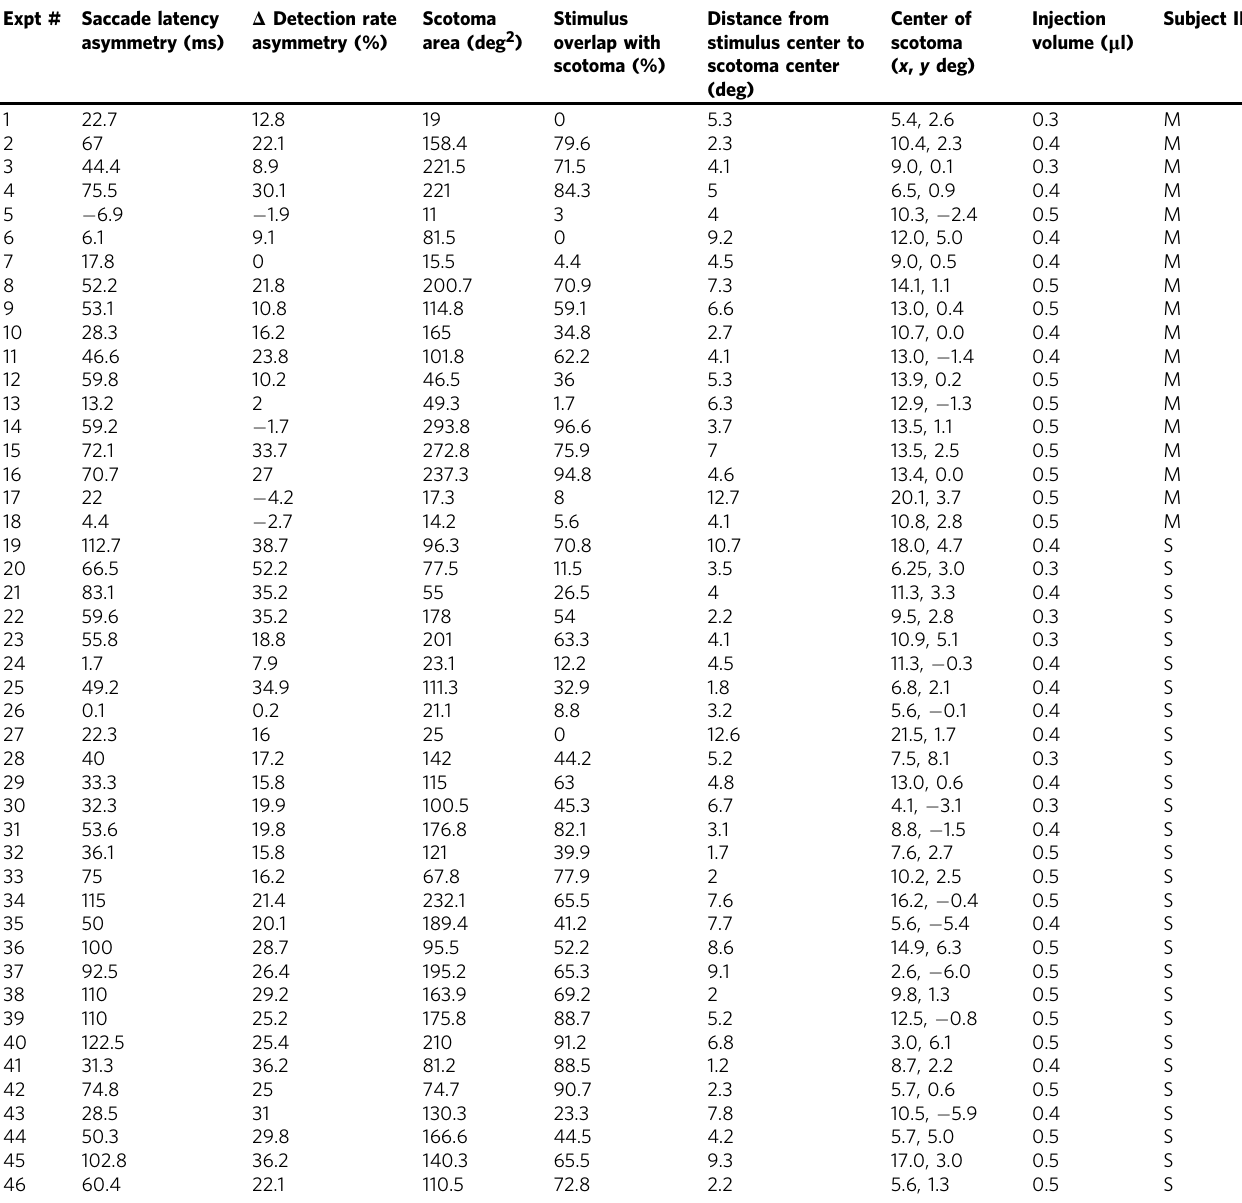
Table 1 Summary of muscimol injections performed in the SC Expt # Saccade latency asymmetry